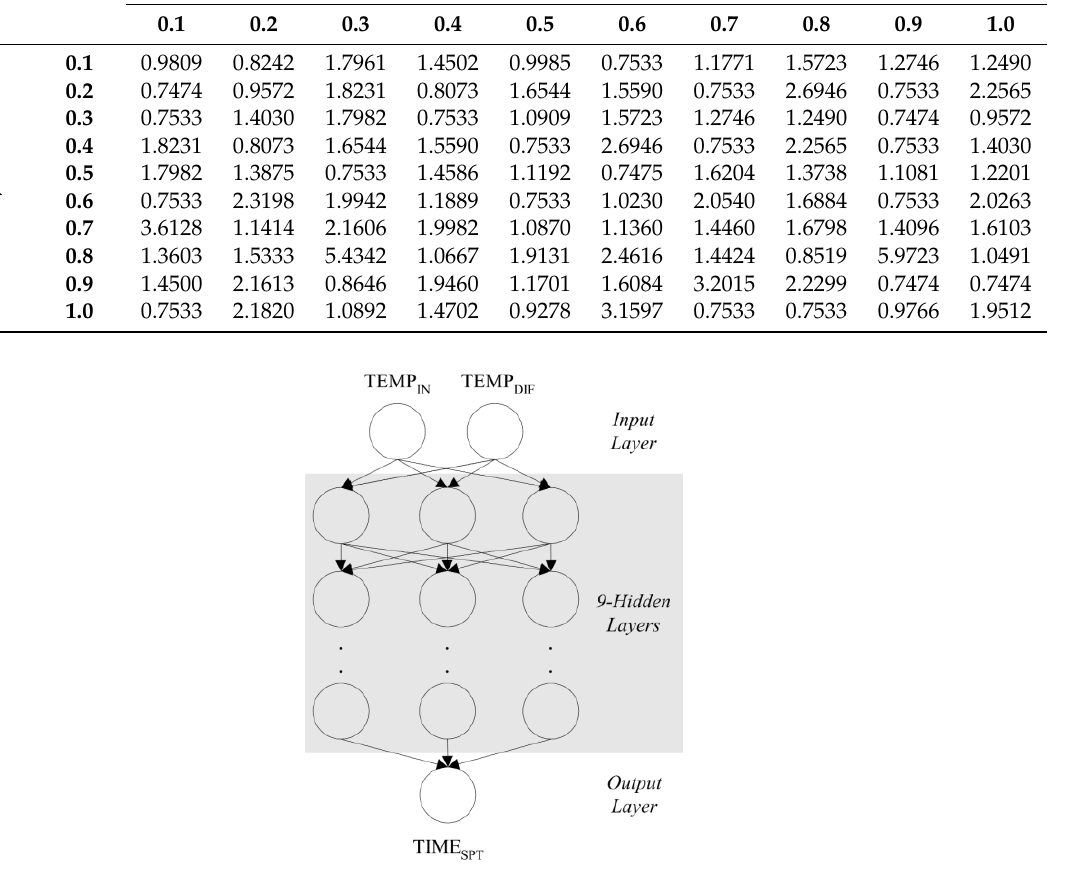
Figure 9. The optimized ANN model.